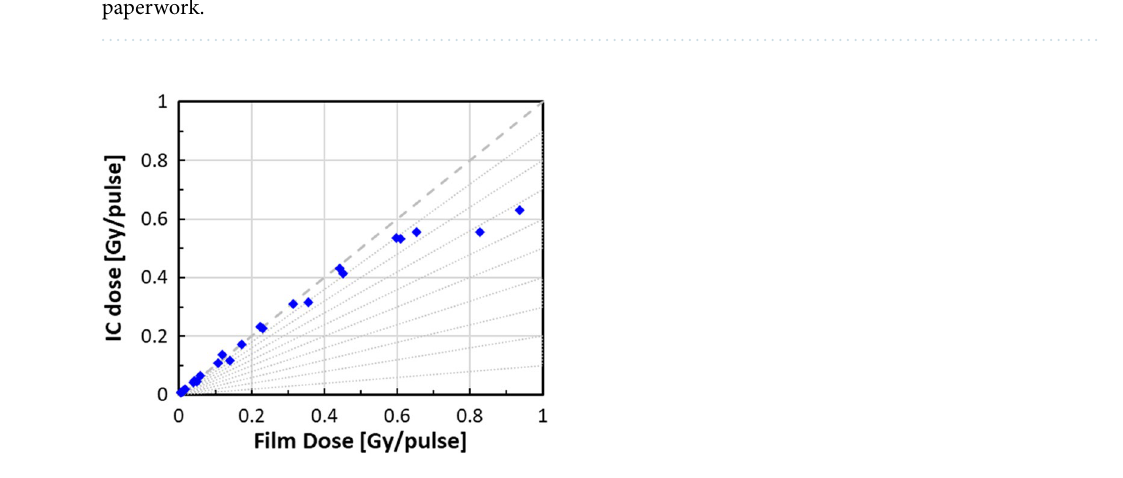
Figure 5. Measurement of recombination corrections to the AMIC. The Dashed line corresponds to 100% collection efficiency. The dotted lines represent 10% decreases in collection efficiency. Up to about 0.5 Gy/pulse the AMIC reports the correct